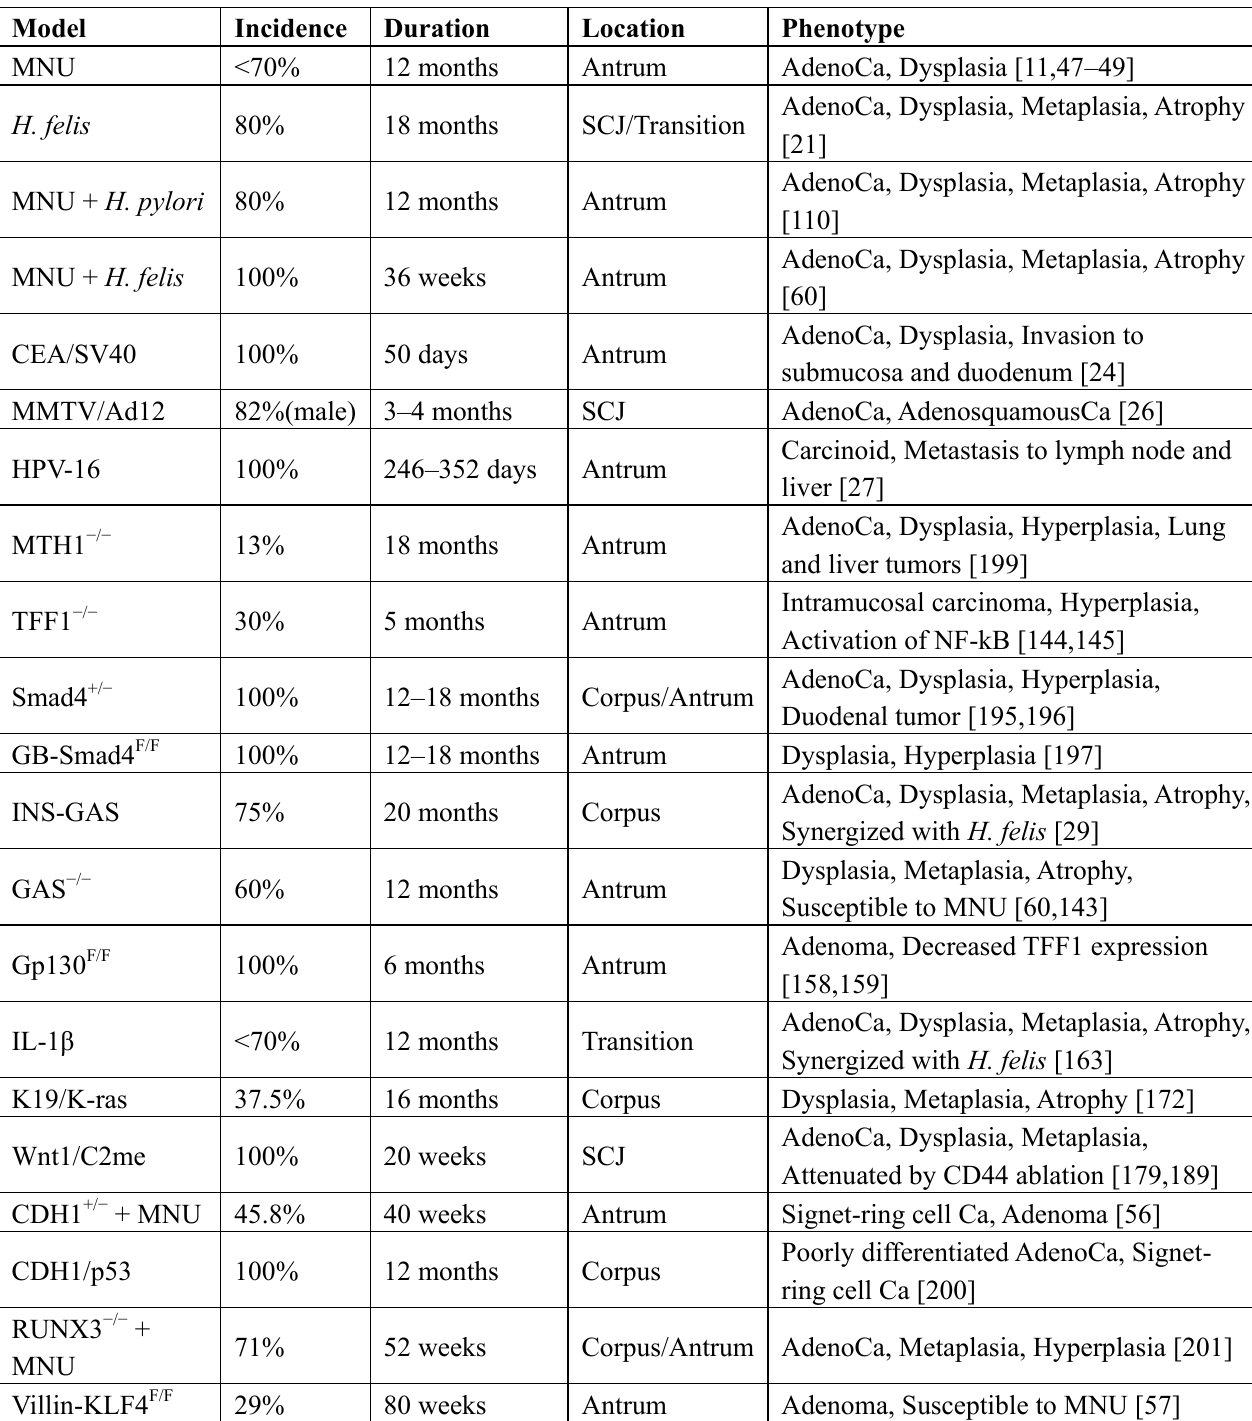
Table 2. Mouse models of gastric